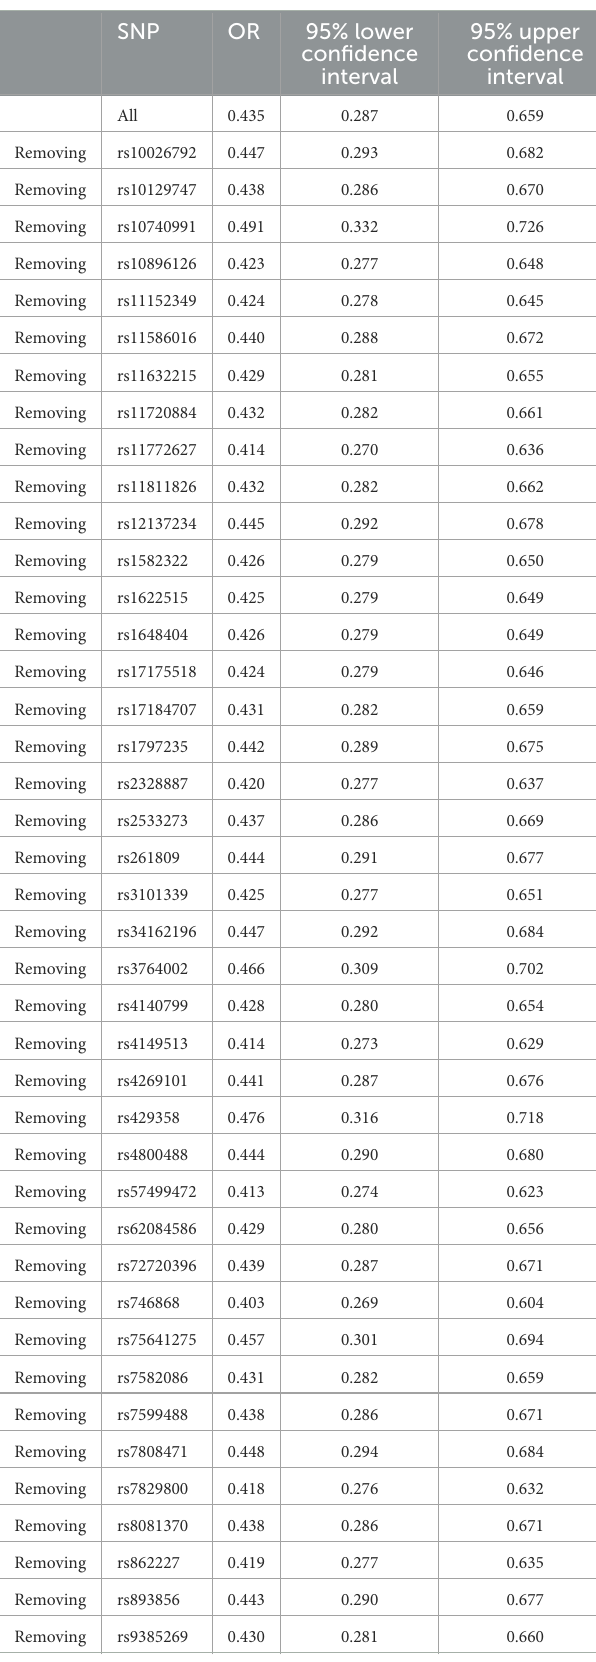
TABLE 3 Leave-one-out analysis using the inverse variance weighted